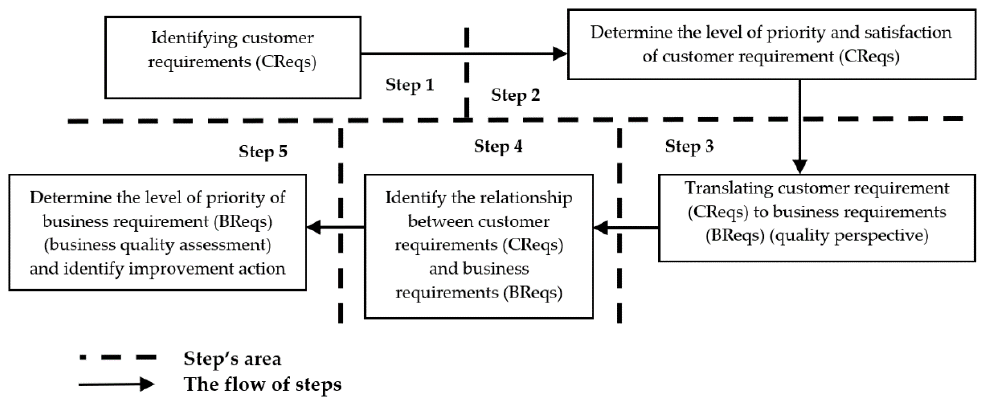
Figure 1. Research framework . 248